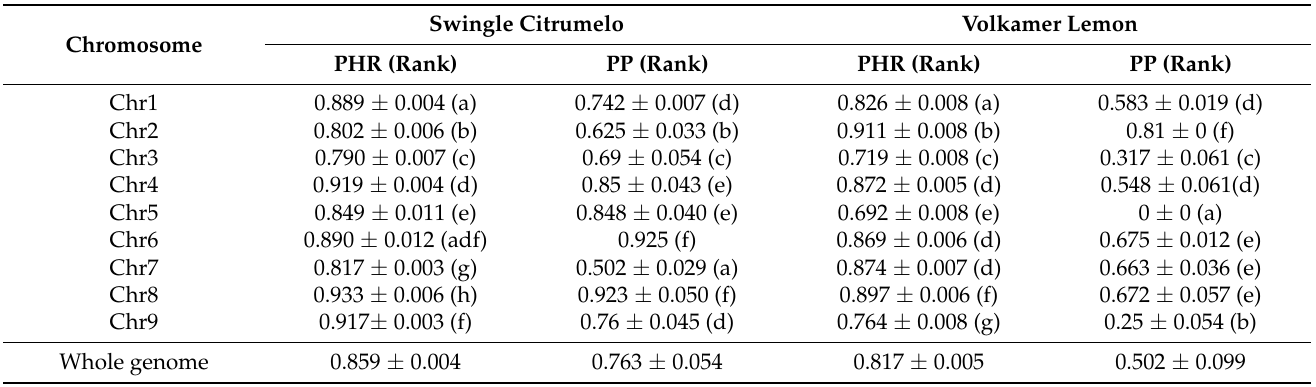
Table 3. Parameters of the meiotic behaviors of the tetraploid Swingle citrumelo and tetraploid Volkamer lemon.